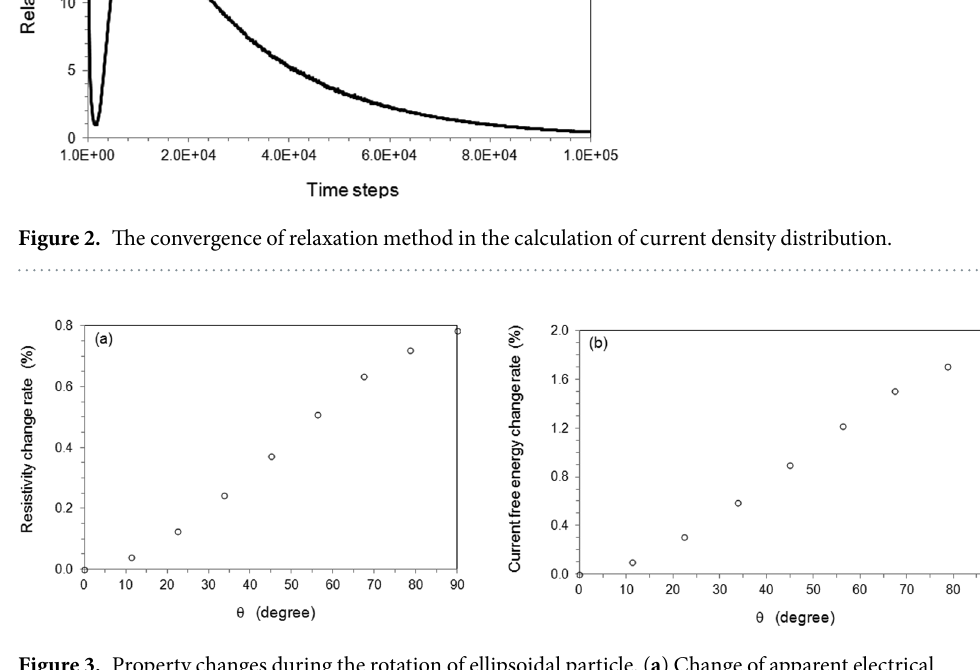
Figure 3. Property changes during the rotation of ellipsoidal particle. ( a ) Change of apparent electrical resistivity of system; ( b ) Change of apparent electric current free